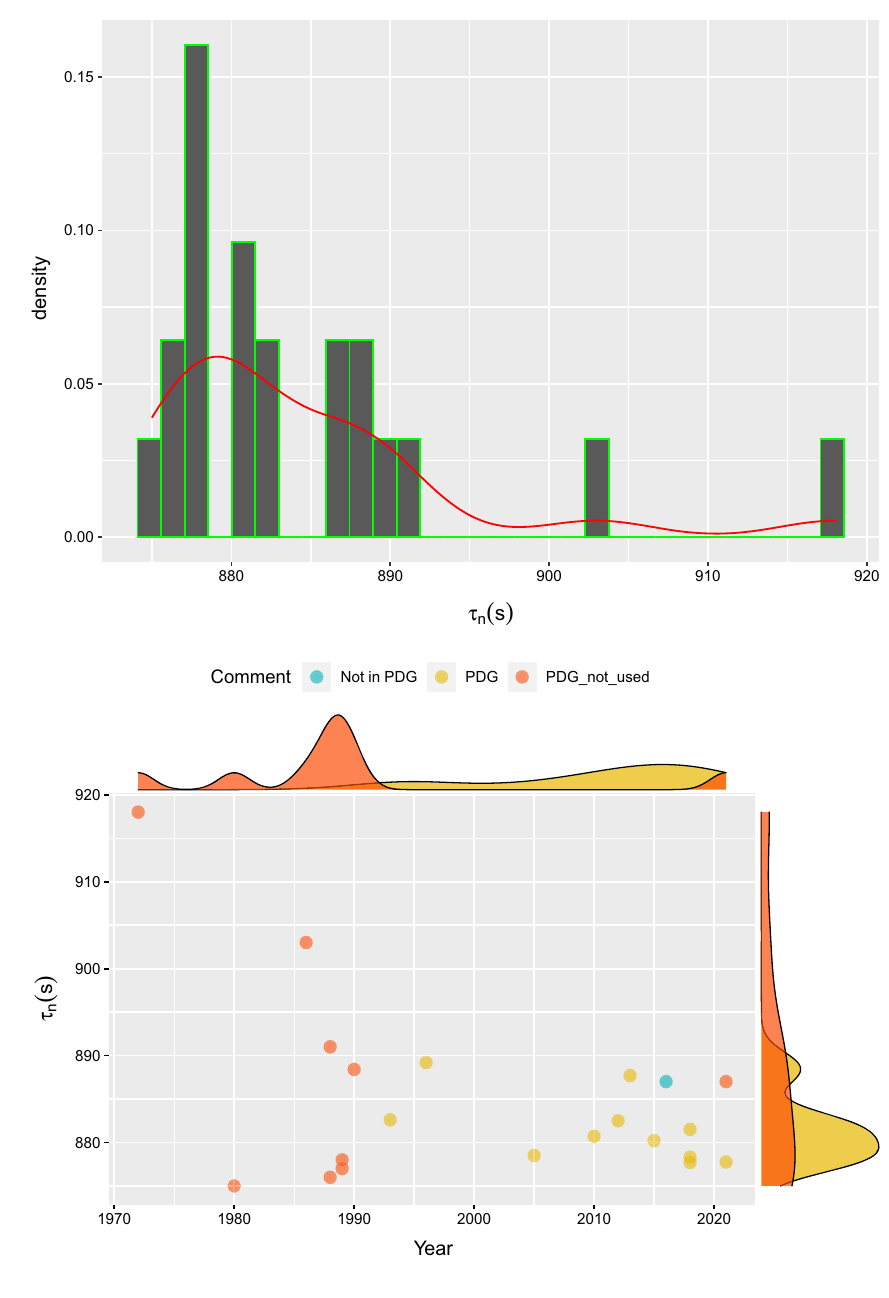
Fig. 1 Histogram and probability density (red line) of neutron lifetime measurements